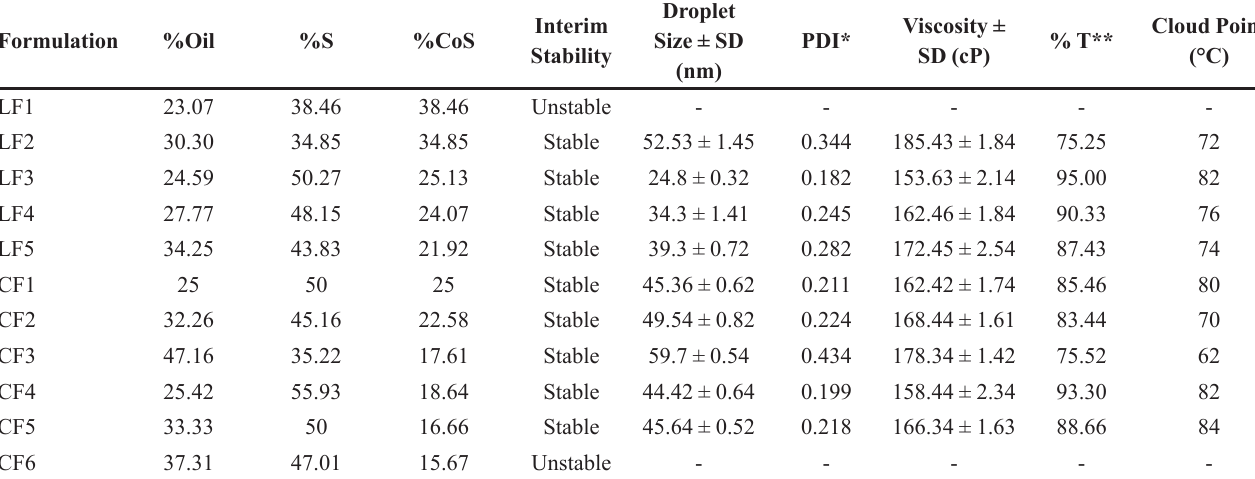
TABLE V - Droplet size, polydispersity index, viscosity, percentage transmittance and cloud point of liquid SNEDDS